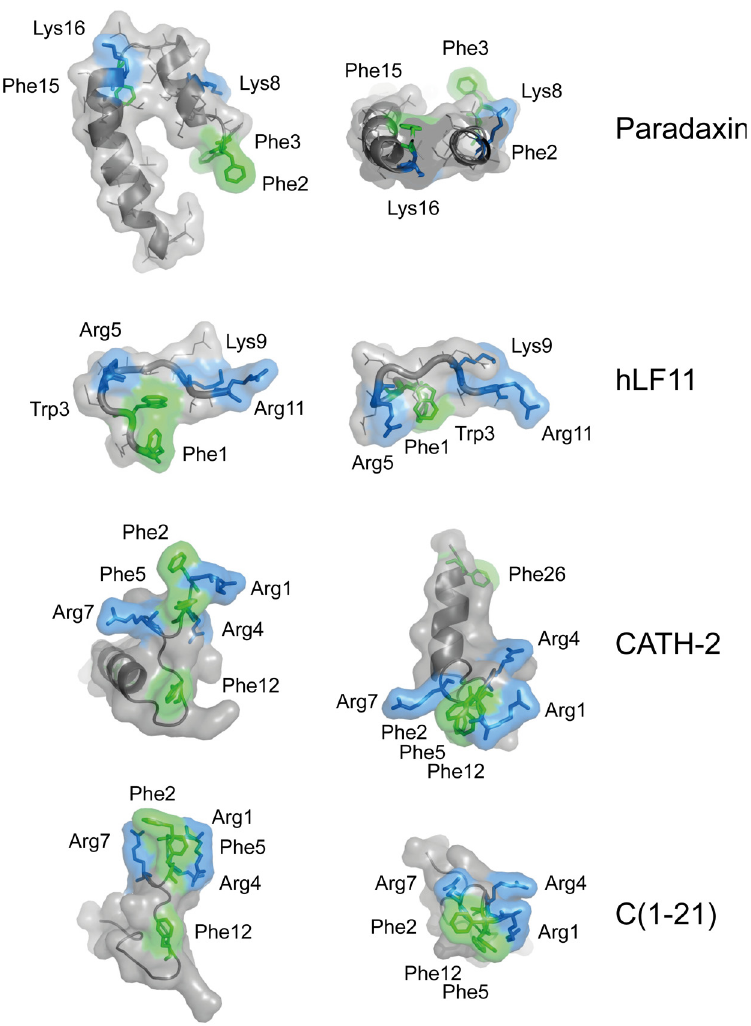
Fig 6. Structural representation of LPS-neutralizing CATH-2 and C1-21 peptide. Representations of the known 3-dimensional structure of paradaxin and human lactoferrin-derived peptide hLF11, cationic peptides with known LPS-binding affinity and the deduced structures of CATH-2 and C(1 – 21). Side chains reported or deduced to be in closest proximity to lipid A are depicted in green (aromatic side chains) and blue (basic side chains). Representations were adapted from the published structures (RSCB Protein Data bank; http://www. rcsb.org/pdb/home/home.do). The structure of CATH-2 analog C(1 – 21) was predicted using